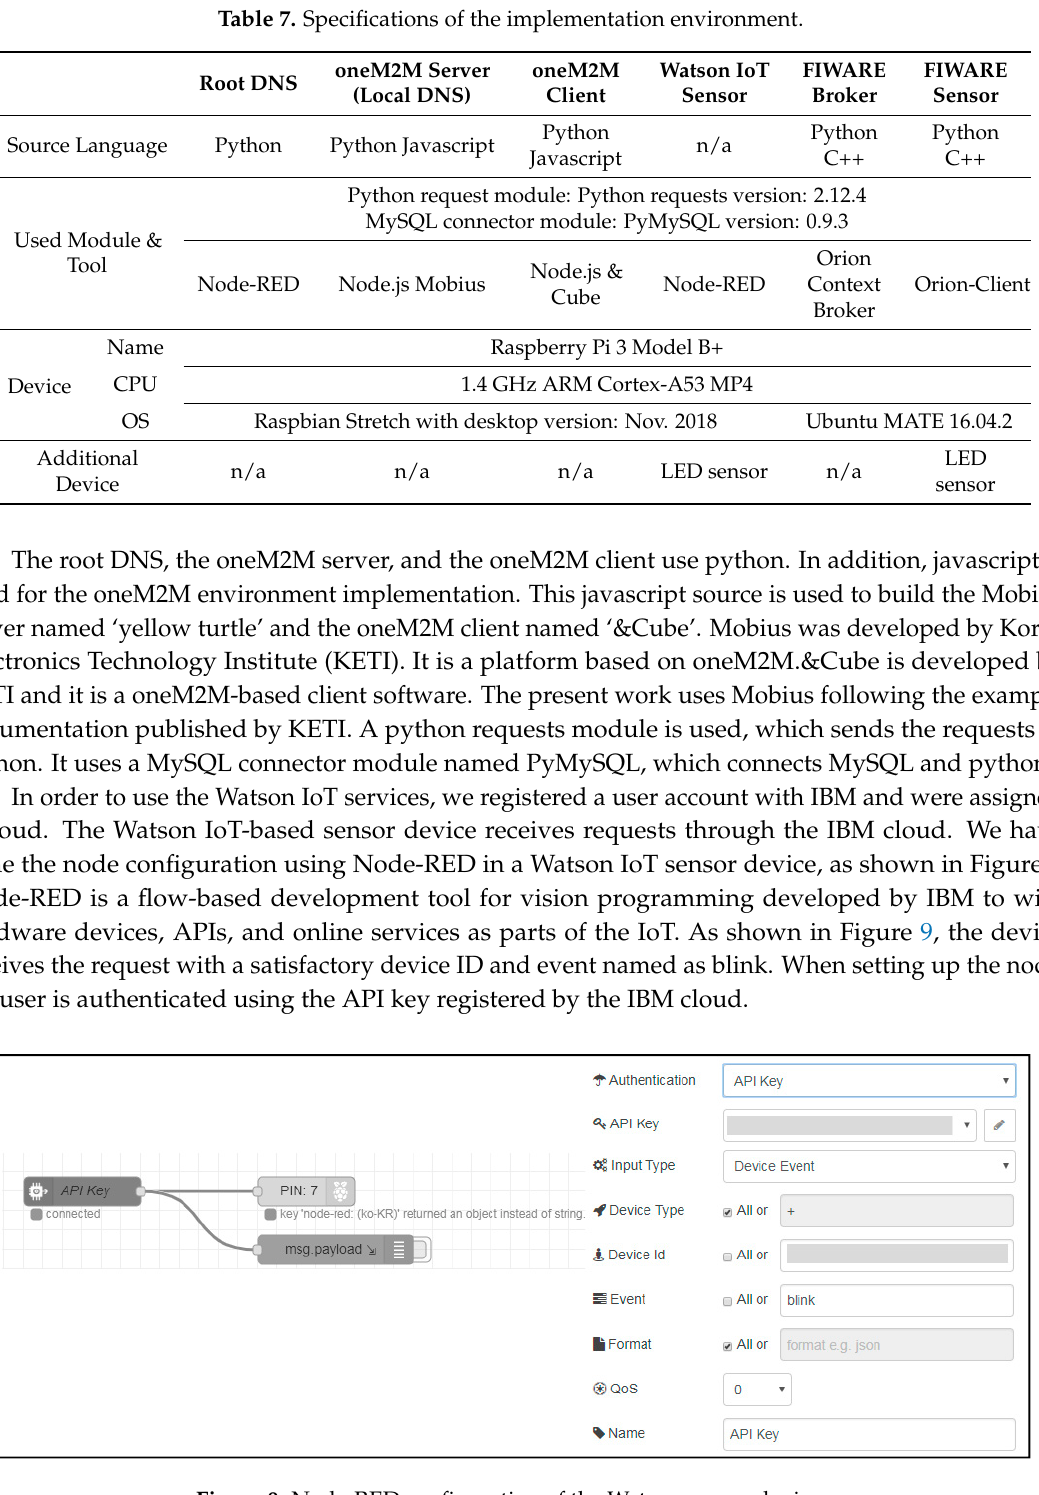
Figure 9. Node-RED configuration of the Watson sensor device.